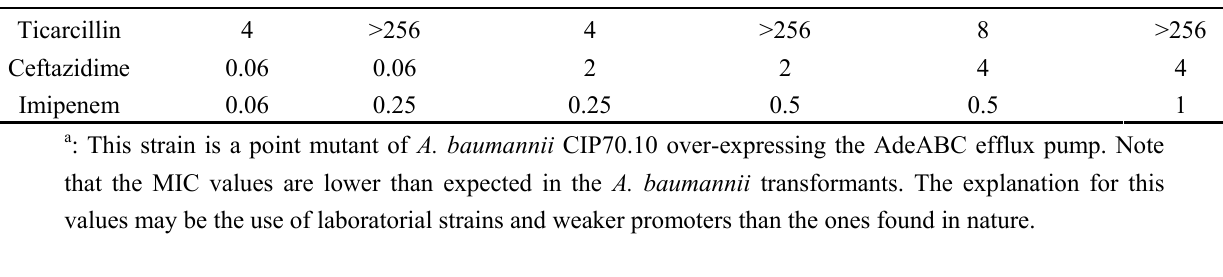
Table 4. MICs for OXA-58 in different background strains (adapted from [37]).